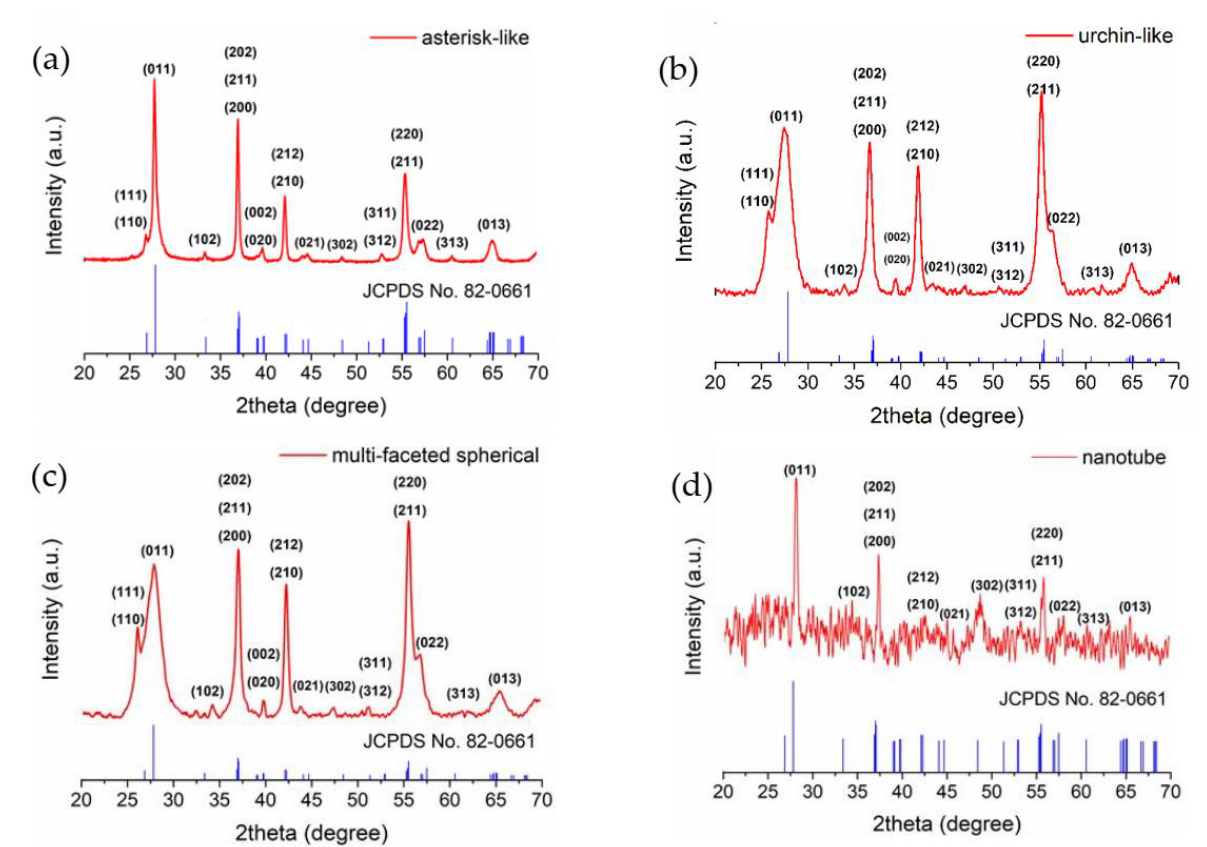
Figure 2. XRD spectrum of VO 2 nanoparticles with different morphologies: ( a ) asterisk-like ( b ) urchin-like, ( c ) multifaceted spherical ( d ) nanotube. Standard XRD pattern is plotted in blue.